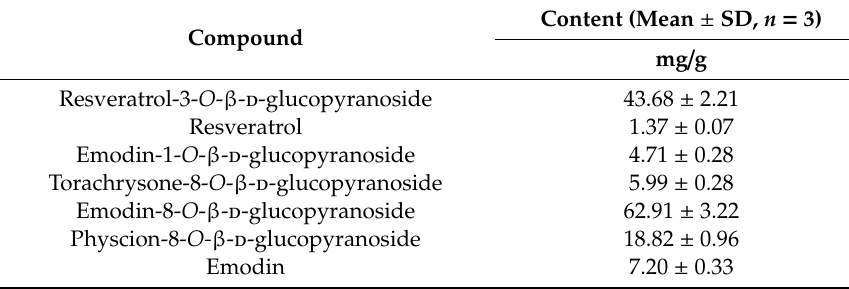
Table 1. Contents of marker compounds in